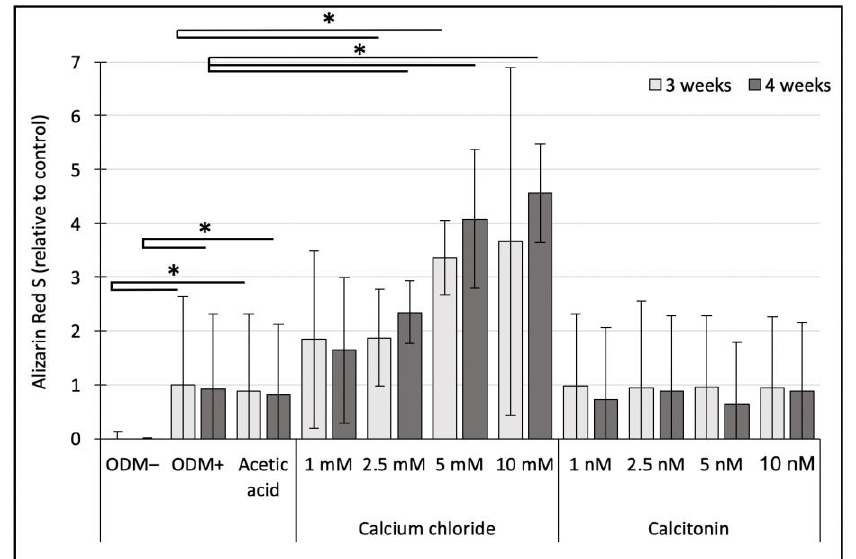
Figure 2. Photometric quantification of alizarin red S in murine MC3T3-E1 cells. Cells were incubated with increasing concentrations of calcium chloride (1, 2.5, 5, and 10 mM) or calcitonin (1, 2.5, 5, and 10 nM) for three or four weeks. Concentrations of alizarin red S are represented relative to the ODM+ reference after three weeks. Values represent means of three independent experiments in triplicate (n = 9) except for ODM+ reference (n = 12), the negative control ( ODM− ; n = 6) and the acetic acid control (n = 6) ± standard deviation. ODM; osteoblast differentiation medium. * Indicates a significant difference ( p < 0.05).